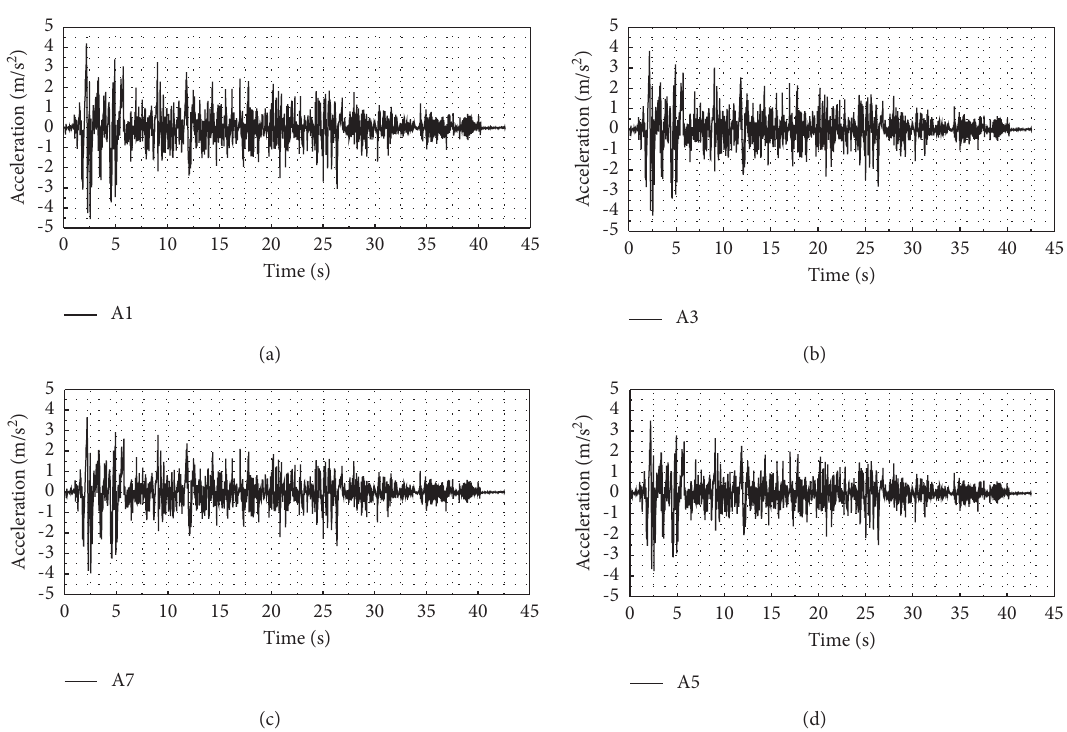
Figure 7: Acceleration spectrum curve of different measuring points. (a) 0.3g A1 acceleration-time history. (b) 0.3g A3 acceleration-time history. (c) 0.3g A7 acceleration-time history. (d) 0.3g A5 acceleration-time